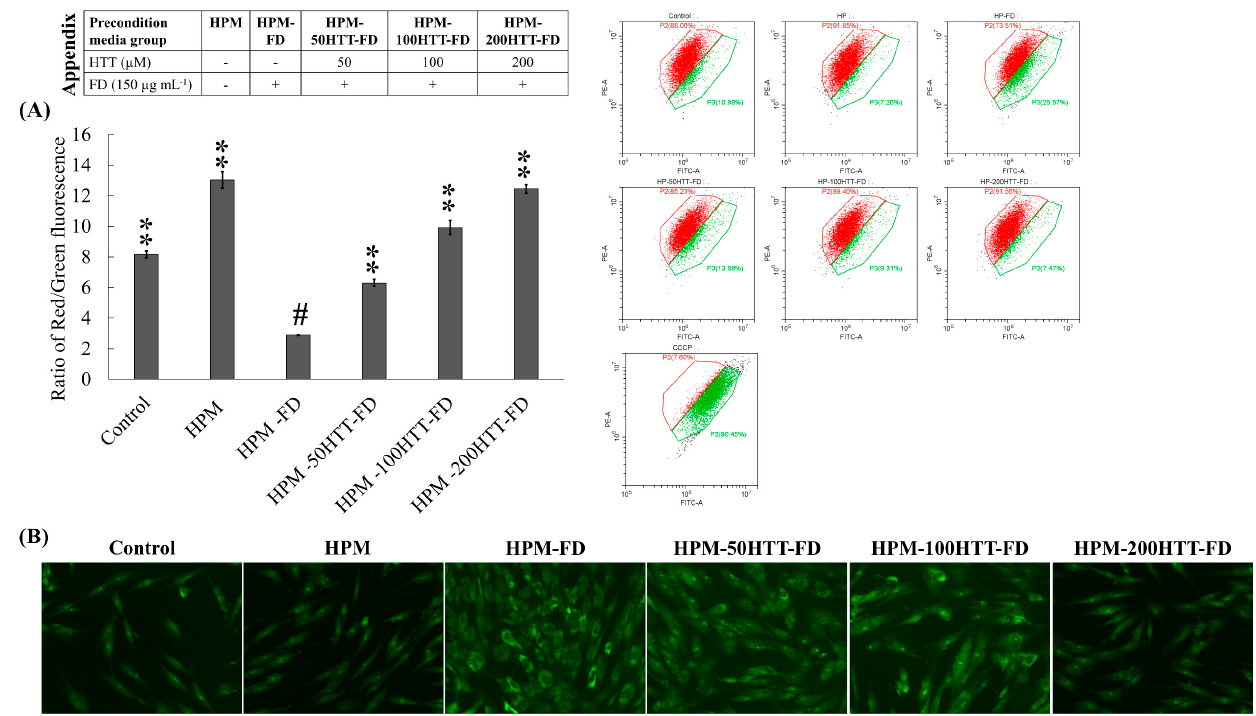
Figure 2. Effect of HTT priming in FD-stimulated HaCaT keratinocyte preconditioned media on mitochondria depolarization and HDF differentiation. ( A ) Mitochondria depolarization as assessed by flow cytometric JC-1 assay. ( B ) Evaluation of nuclear morphology and HDF differentiation by nuclear double staining. Evaluations were carried out in triplicates ( n = 3) and indicated as means ± SD. “**” respectively denote p < 0.01 if they are significantly different from those of HPM-FD treated HDFs “#”.